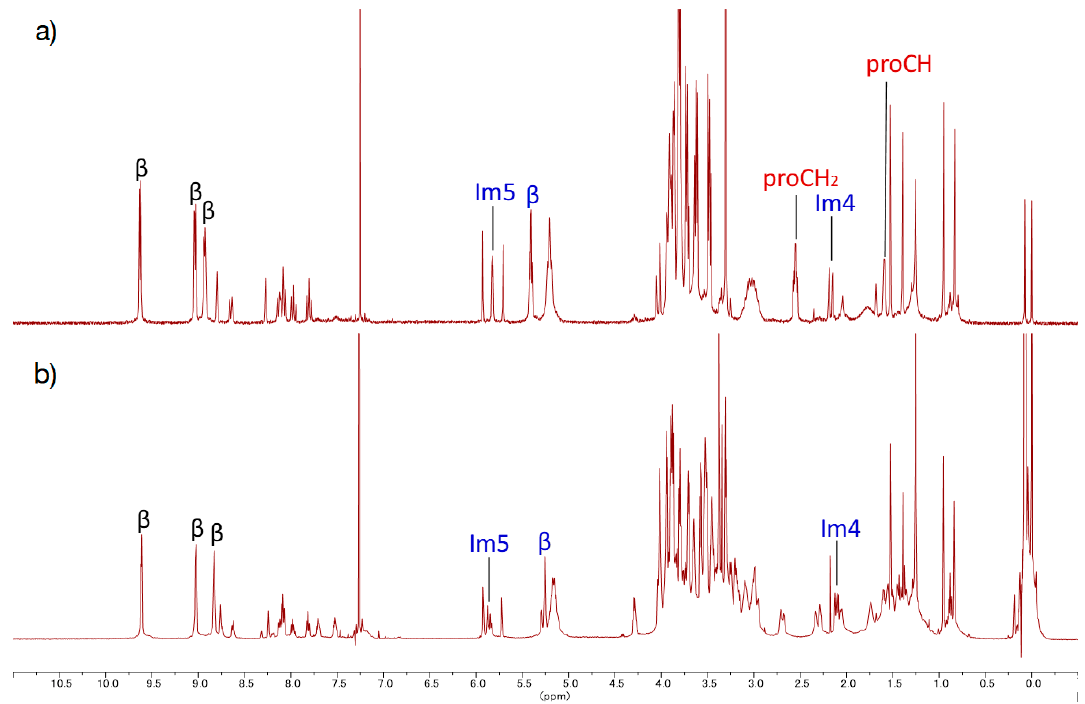
Figure 10. 1 H-NMR (400 MHz, CDCl 3 ) spectra of (top) 5Zn and (bottom) PEG8-5Zn .